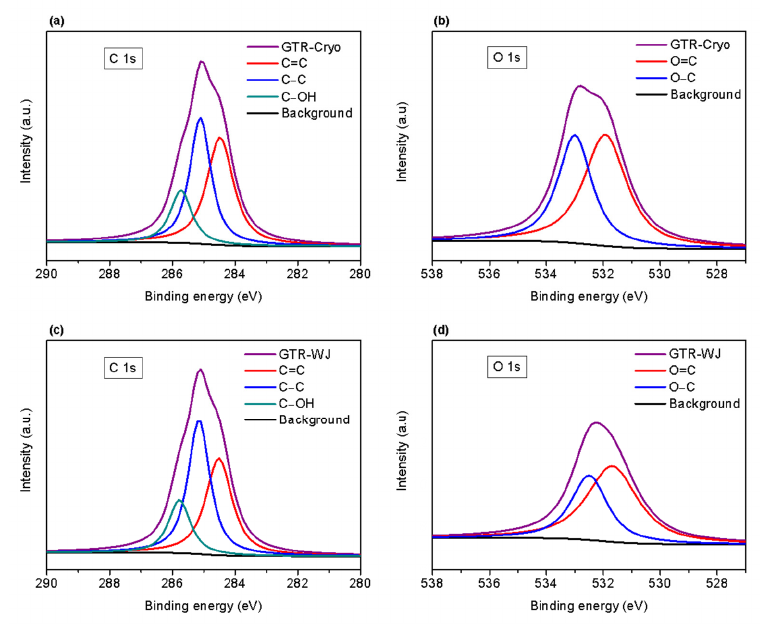
Figure 2. XPS C and O core spectra of: ( a , b ) GTR-Cryo and ( c , d ) GTR-WJ.